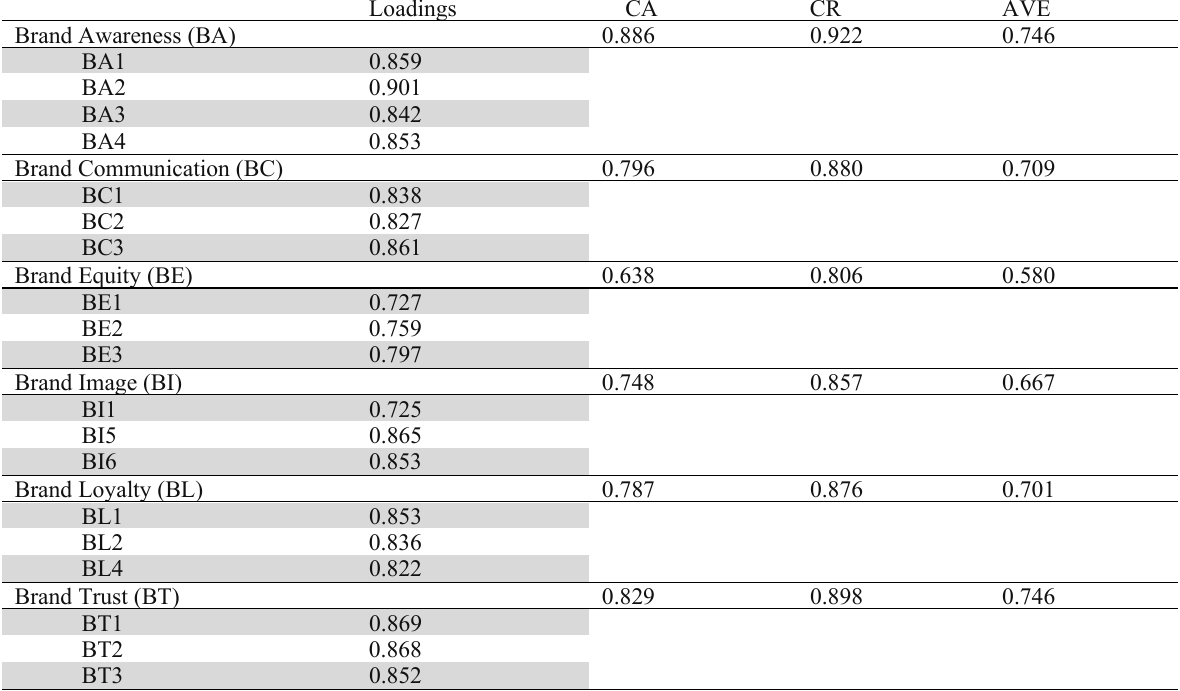
Reliability and convergent validity.